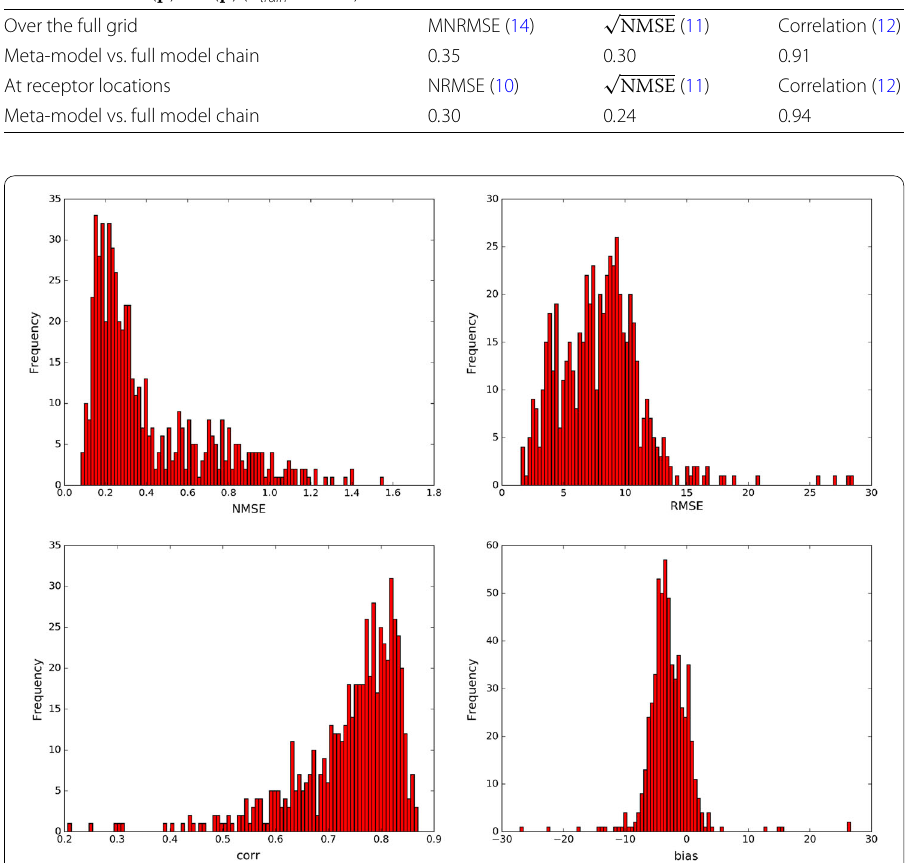
Fig. 10 Scores of the meta-modeled NO 2 concentration field compared to the full model solution, for parameters over the month of November 2014. Top left: NMSE (11). Top right: RMSE (10) ( µ gm − 3 ). Bottom left: correlation (12). Bottom right: bias (13) ( µ gm − 3